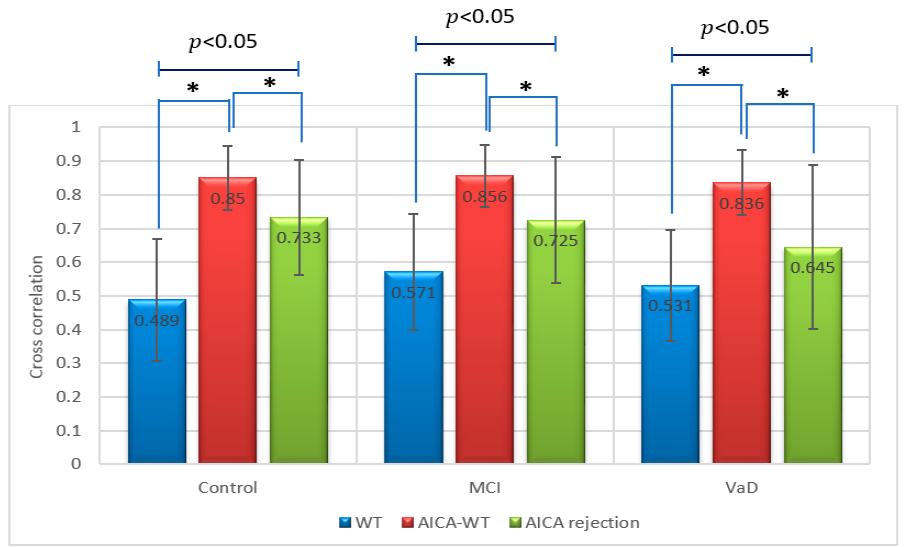
Figure 9. Comparative plot of correlation coefficients between the artifactual EEG signals and the EEG signals after denoising using WT, AICA rejection and AICA–WT techniques for VaD, MCI patients and control subjects. *, indicates a statistically significant difference between groups ( p < 0.05). Sensors 2017 , 17 , 1326